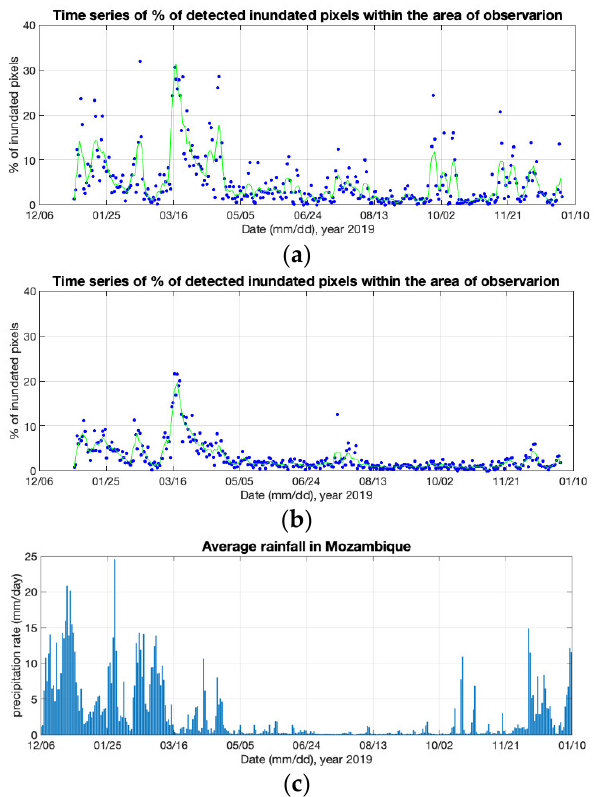
Figure 11. Time series of the observed % flooded pixels for 1-year of data, using ( a ) SNR observable and ( b ) TES observable. The daily rainfall averaged over all pixels of the Mozambique area under study during 2019 is shown in ( c ), where data has been obtained from TRMM (TMPA-RT) Near Real-Time Precipitation L3 1 day 0.25 degrees × 0.25 degrees V7 (TRMM_3B42RT_daily) at GES DISC, through the NASA Earth Data website [60].